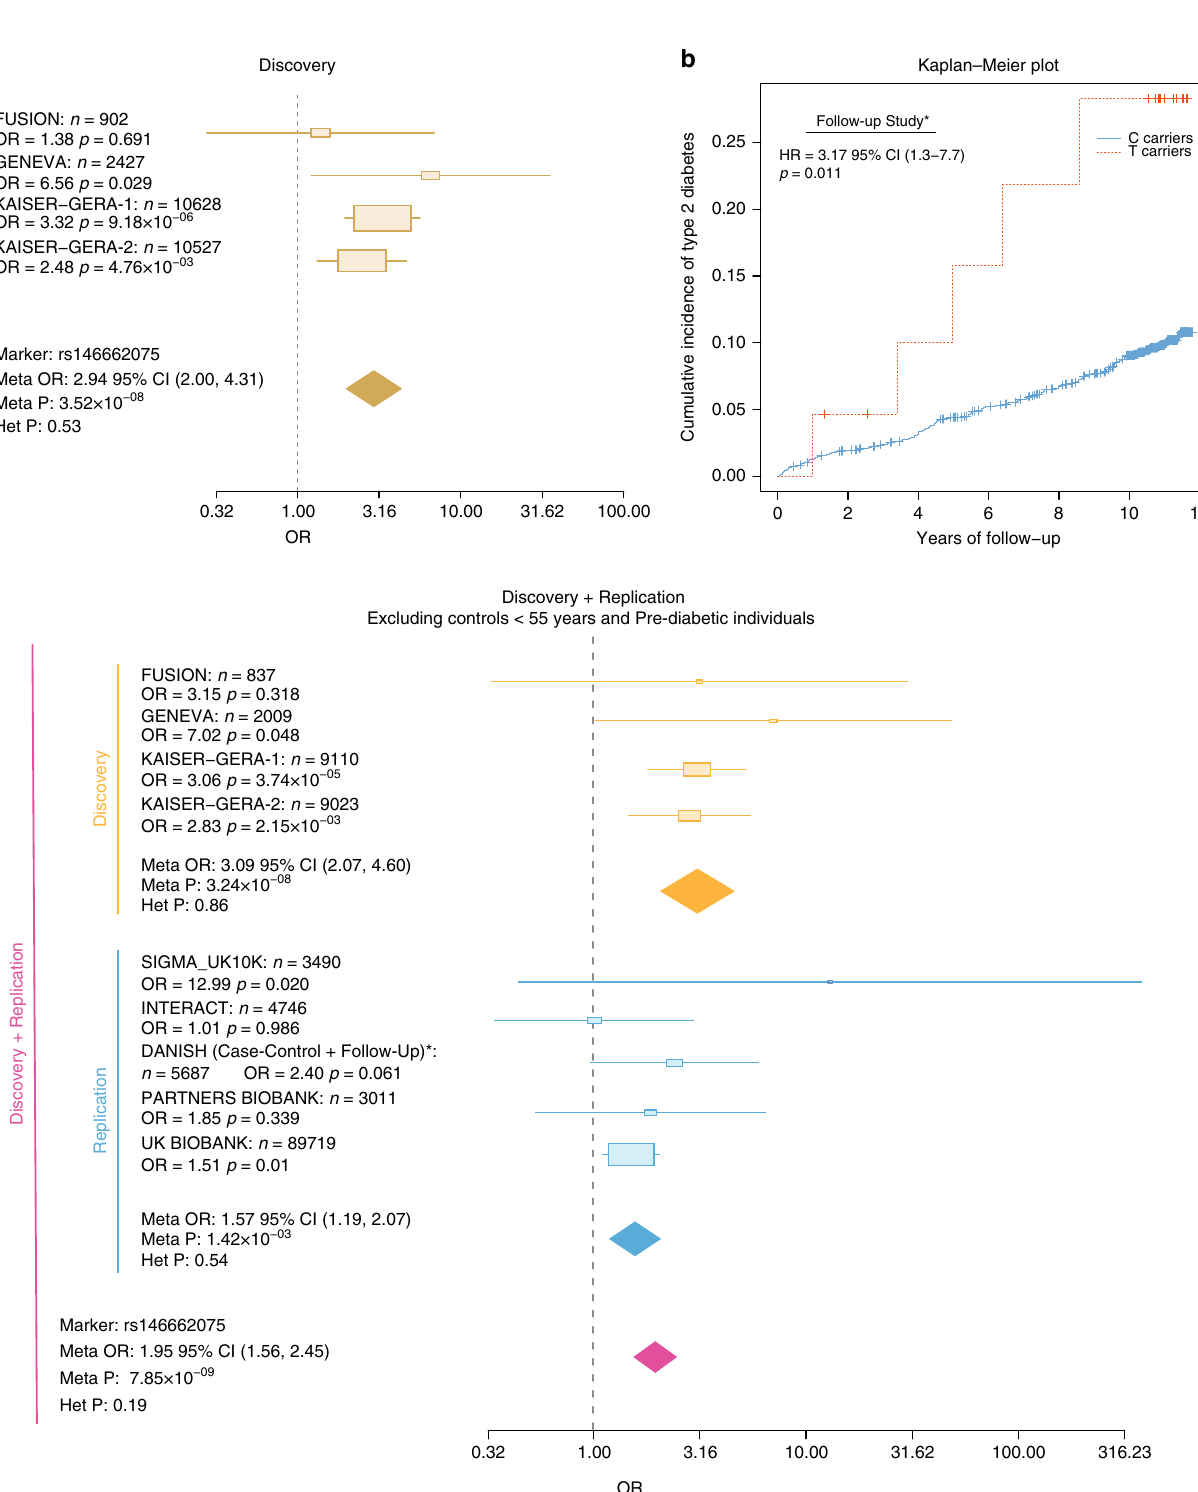
Fig. 3 Discovery and replication of rs14666075 association signal. a Forest plot of the discovery of rs146662075 variant. Cohort-speci fi c odds ratios are denoted by boxes proportional to the size of the cohort and 95% CI error bars. The combined OR estimated for all the data sets is represented by a diamond, where the diamond width corresponds to 95% CI bounds. The p -value for the meta-analysis (Meta P) and for the heterogeneity (Het P) of odds ratio is shown. b Kaplan – Meier plot showing the cumulative incidence of T2D for a 11 years follow-up. The red line represents the T carriers and in light blue, C carriers are represented ( n = 1,652, cases = 158). c Forest plot after excluding controls younger than 55 years, OGTT > 7.8 mmol l − 1 , and controls with family history of T2D in both the discovery and replication cohorts when